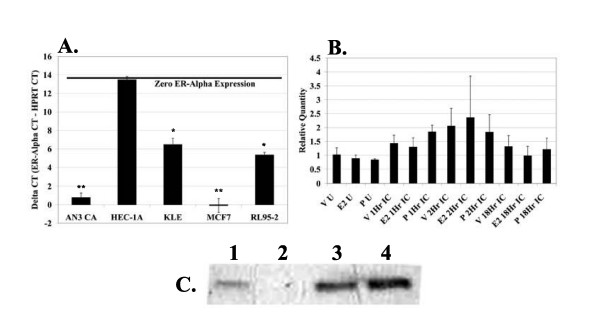
Endometrial epithelial cells express ERα mRNA and protein. (A) cDNA was synthesized from 100 ng of RNA isolated and subjected to quantitative Real Time RT-PCR using primer/probe sets for HPRT and ERα. Delta CT was calculated as follows: ERα CT – HPRT CT. ERα quantities ± SD from samples in triplicate are shown, with cell lines expressing the highest levels of ERα mRNA demonstrating the lowest Delta CT value. The Delta CT value representative of zero expression of ERα is shown (black bar). Statistical analysis was determined using ANOVA (P < 0.05). One asterisk (*) represents statistical significance as compared to bars with no asterisk. Two asterisks (**) represents statistical significance as compared to (*) and bars with no asterisk. (B) cDNA was synthesized from 100 ng of RNA isolated and subjected to quantitative Real Time RT-PCR using primer/probe sets for HPRT and ERα. Average ERα quantities (RQ values) ± SD from samples in triplicate are shown by using the housekeeping gene, HPRT, to normalize samples. (C) Protein lysates from endometrial and breast epithelial cell lines were collected and 10 μg of protein was analyzed for presence of ERα protein (67 kD) by Western Blot. Samples shown are as follows: (1) RL95-2 cells positive for ERα mRNA by endpoint RT-PCR, (2) RL95-2 cells negative for ERα mRNA by endpoint RT-PCR, (3) and (4) MCF7 positive control.